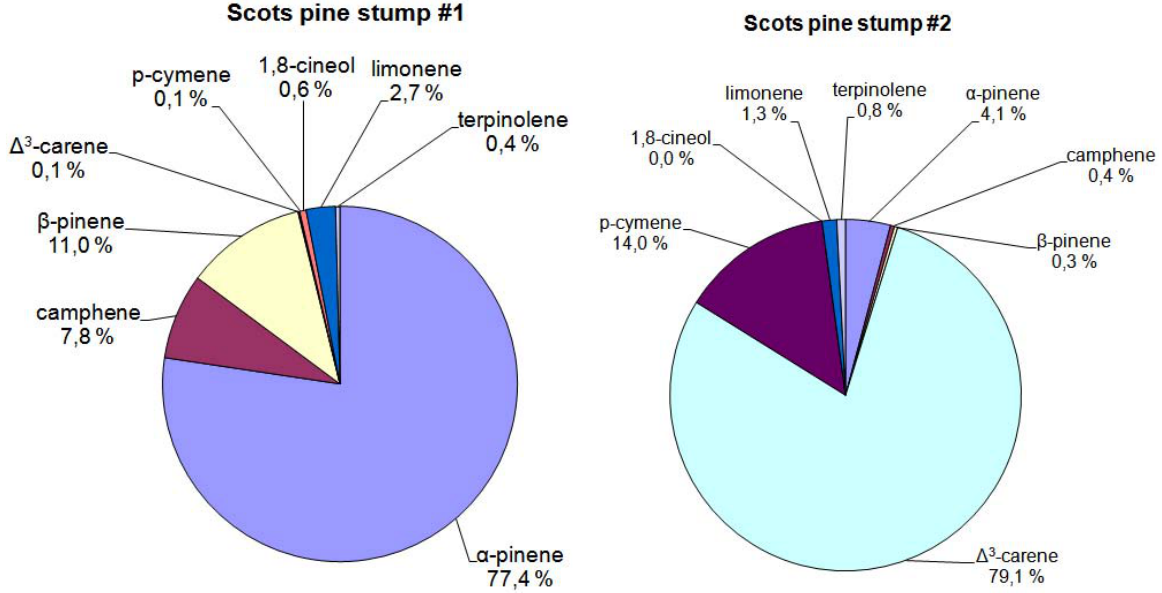
Fig. 1. The monoterpene emission spectra of the two individual Scots pine